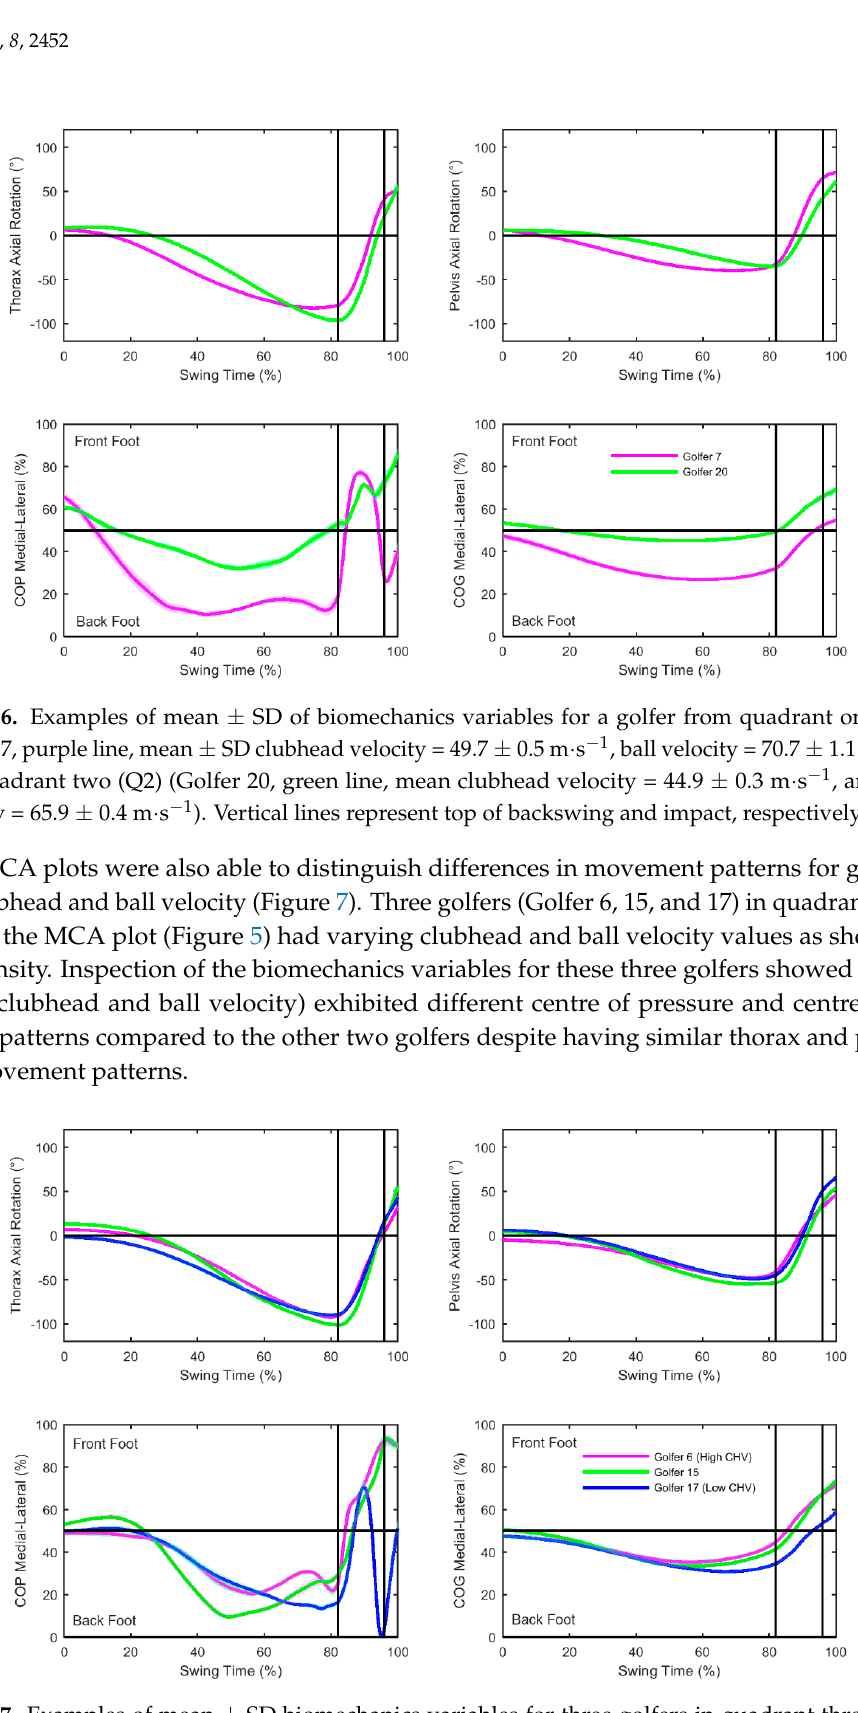
Figure 7. Examples of mean ± SD biomechanics variables for three golfers in quadrant three (Q3), with varying clubhead velocity (Golfer 6, purple line, mean ± SD clubhead velocity = 48.8 ± 0.3 m·s − 1 , Golfer 15, green line, clubhead velocity = 43.7 ± 0.4 m·s − 1 , Golfer 17, blue line, clubhead velocity = 41.8 ± 0.3 m·s − 1 ). Vertical lines represent top of backswing and impact, respectively.